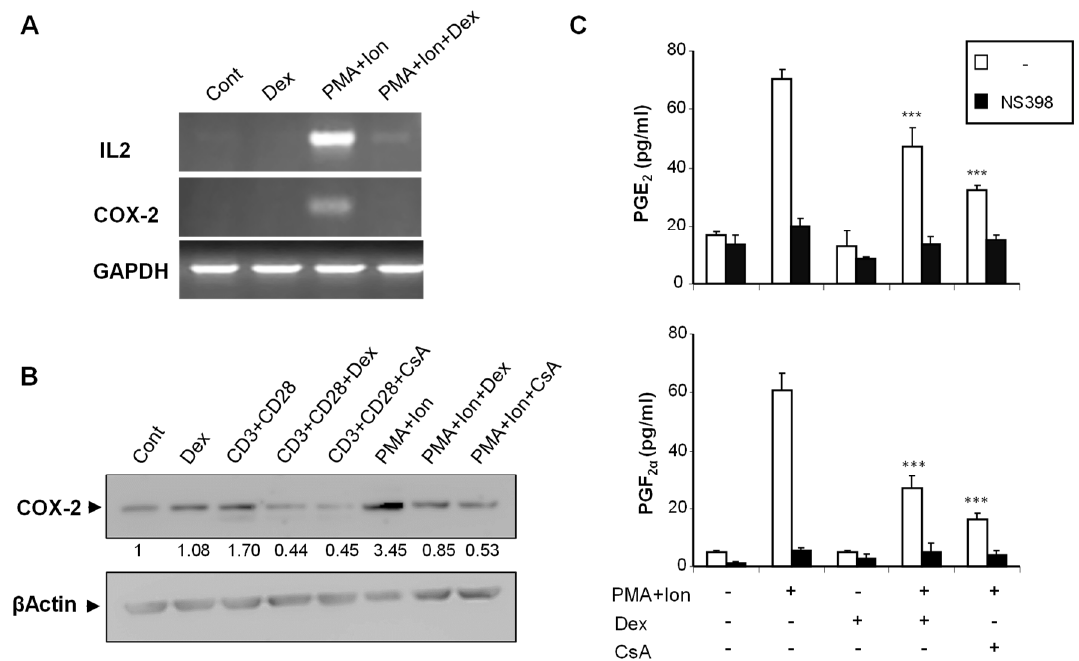
Figure 1. Dex inhibits COX-2 induction in activated human T cells. Purified human T cells were treated with PMA (15 ng/mL) plus Ca ++ ionophore (Ion; 1 µ M) or with anti-CD3/CD28 Abs (5 µ g/mL; 1 µ g/mL). Dex (1 µ M) or CsA (100 ng/mL) was added 1 h before stimulation. ( A ) Levels of IL2, COX-2, and GAPDH mRNAs were determined by RT-PCR. An aliquot of the amplified DNA was separated on an agarose gel and stained with ethidium bromide for qualitative comparison. ( B ) COX-2 protein levels were analyzed by Western blot using anti-COX-2 mAb. β -Actin levels were determined as a control of loading. Numbers below the bands indicate COX-2 protein levels measured as the intensity of each band relative to β -Actin. ( C ) PGE2 and PGF2 α were measured in supernatants of T cells treated with PMA + Ion, Dex, and CsA as indicated. PGs production in the presence or absence of the COX-2 inhibitor NS398 (1 µ M) was determined by an EIA assay, as described in Materials and Methods. Results shown are from a representative of two independent experiments performed in triplicate, and are expressed as mean ± SEM. (*** p < 0.001; vs. PMA + Ion treatment).